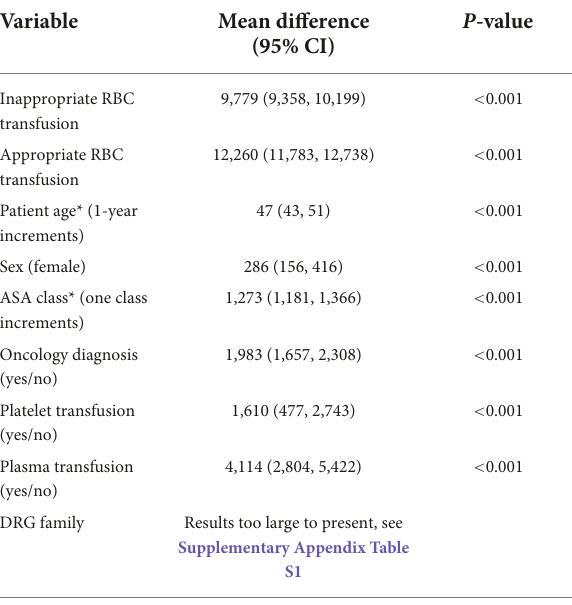
TABLE 2 Regression model for incremental cost (USD) impact of appropriate and inappropriate red cell transfusion on hospital costs after adjusting for confounding